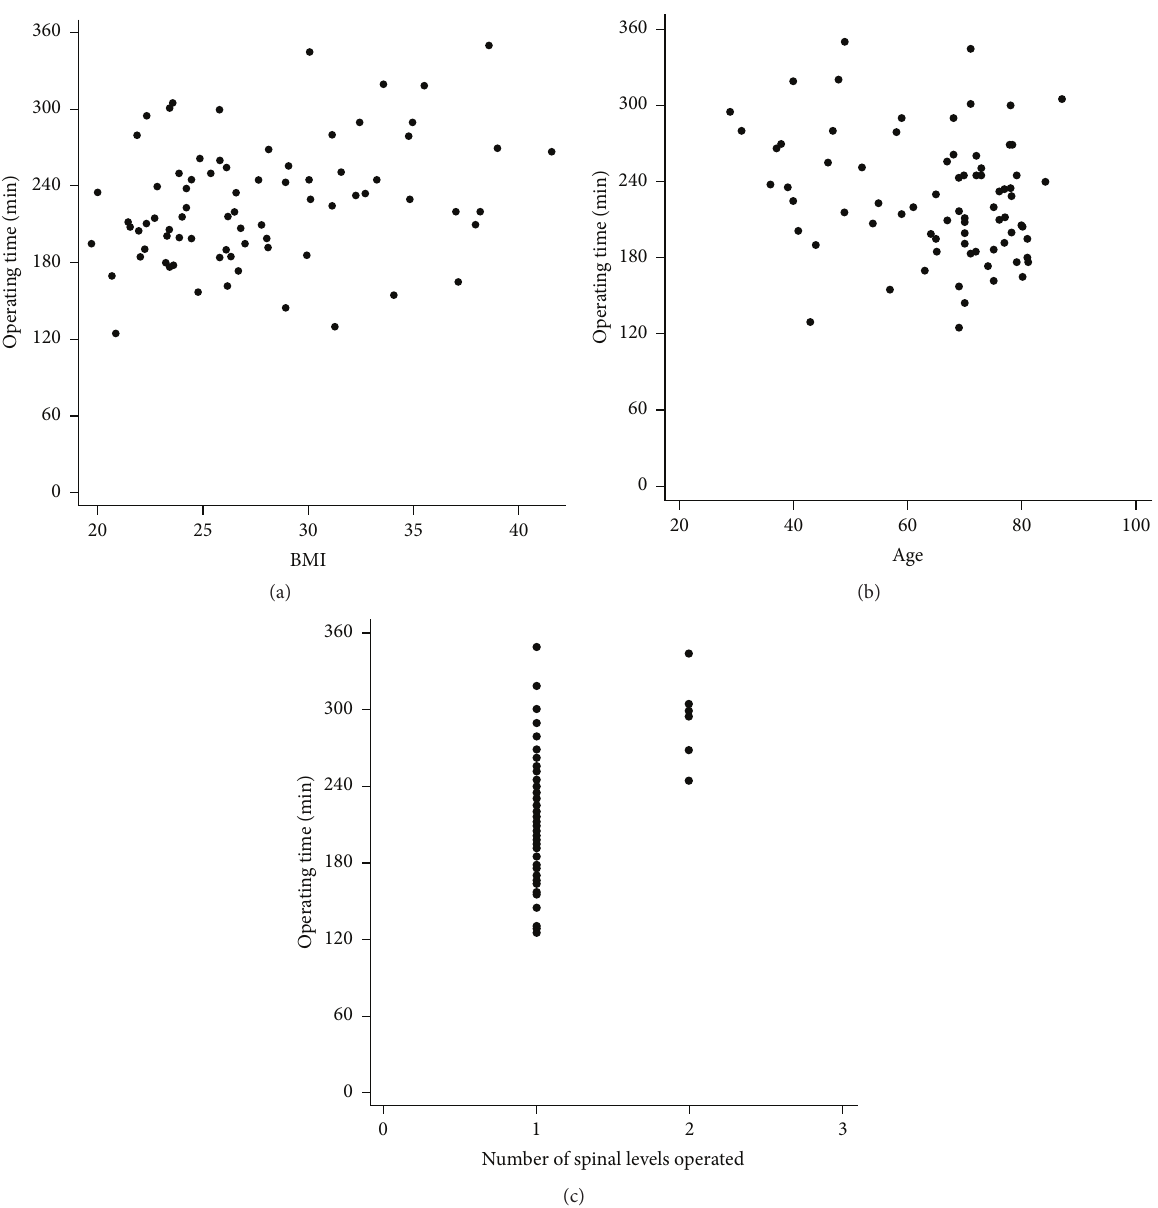
Figure 3: Influence of BMI on operating time. The graph shows a scatter-plot of the BMI and operating time data. The thumbnails are similar scatter-plots showing the influence on operating time from age and numbers of levels fused, which were also significant in the overall regression model. It should be kept in mind that each graph shows only the bivariate distribution of operating time and one other variable; the graphs cannot visually adjust or control for the other two significant variables. The statistical parameters for this regression model were as follows: regression slope = 2.56, 95% CI = 0.79 to 4.35, 𝑡 = 2.87, 𝑝 = 0.005, and adjusted 𝑟 2 =